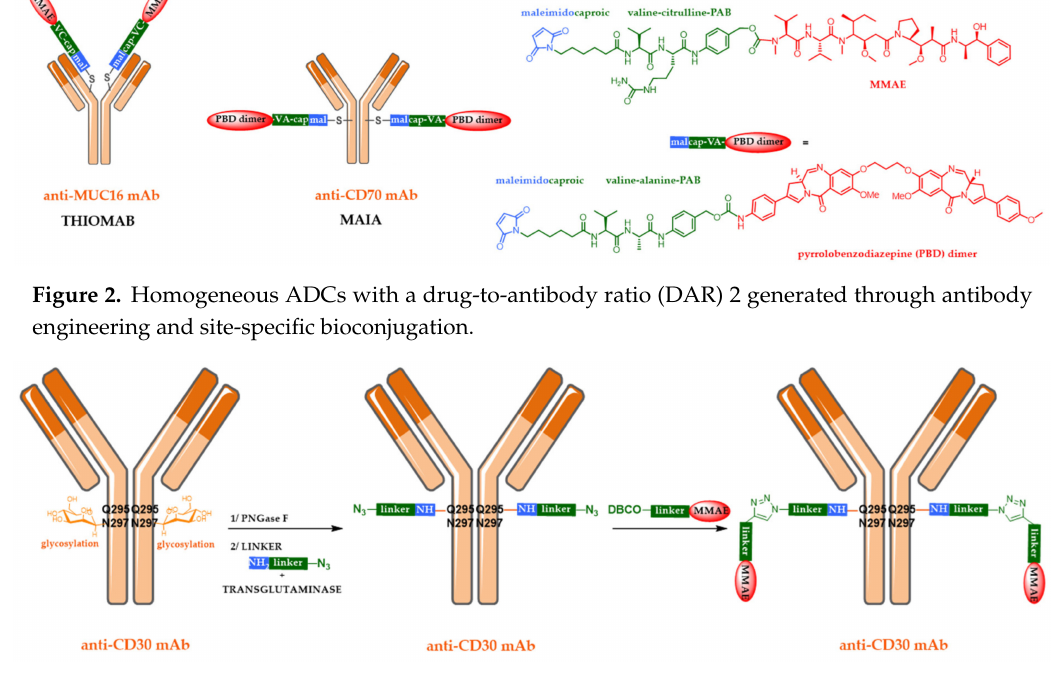
Figure 3. Homogeneous ADC generated by deglycosylation (position Q295), in the presence of PNGase F, followed by a bioconjugation mediated by transglutaminase (position 297). The azide